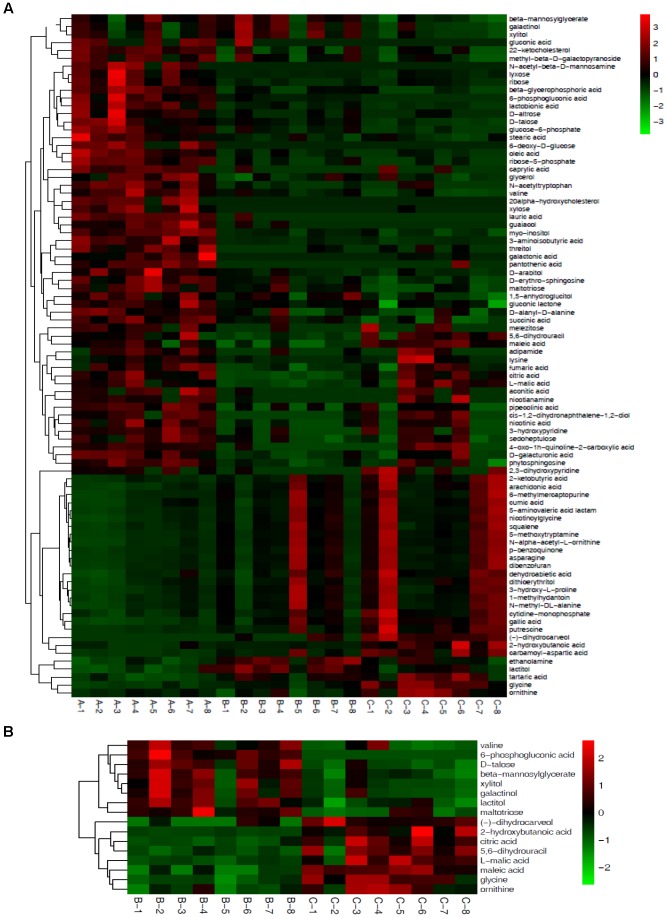
Heat maps of differential metabolites among different mycelia samples. Each mycelium sample is visualized in a single column and each metabolite is represented by a single row. Green colors indicate lower metabolite concentration, while red colors show enhanced metabolite levels (see color scale). See also Table 4. (A) Heat map visualization of differential metabolites among Mycelia A samples, Mycelia B samples and Mycelia C samples. (B) Heat map visualization of differential metabolites between Mycelia B samples and Mycelia C samples.